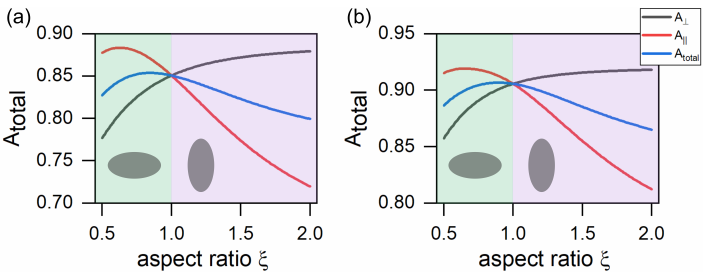
Figure 4. Integral absorption of the PSL in a structure with an aluminum film ( a ) and a photonic crystal ( b